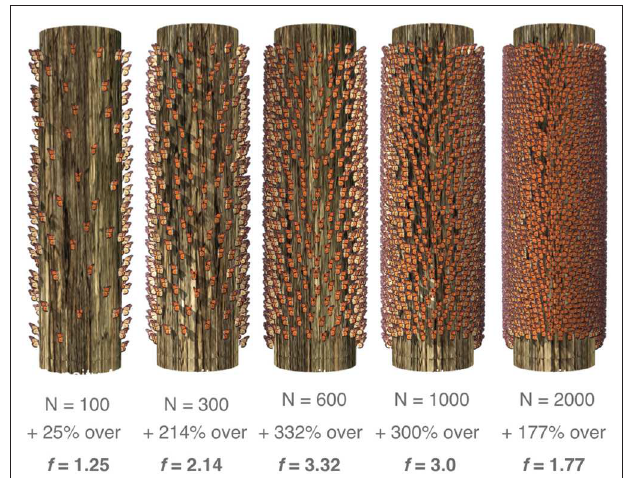
FIGURE 10 | Virtual models of tree trunks covered in different numbers of simulated butterflies. N represents the number of butterflies “placed” on the tree, % represents how much the SVE calculations deviated from the known volume of a single individual and f represents the derived correction factor for each monarch